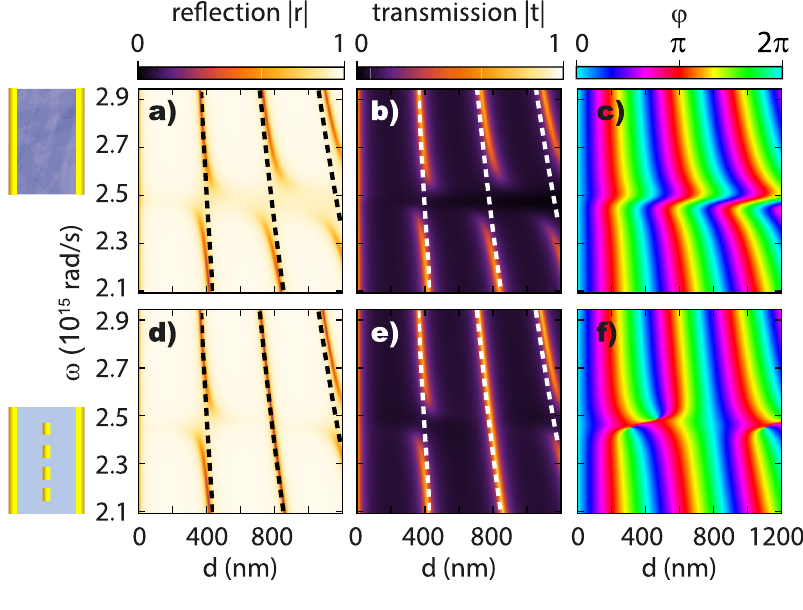
the mode. An apparent difference is that for a metasurface the splitting will reduce with etalon length L (i.e., for higher order modes), while for a cavity completely fi lled with an excitonic medium, the splitting is instead constant. This is due to the fact that in the excitonic case a longer cavity also contains more oscillators, whereas for a metasurface the number of oscillators is fi xed with varying L . Figure 10 shows color plots of the (full, unapproximated) function of frequency and oscillator strength. The zero crossings can be traced as the contour of zero